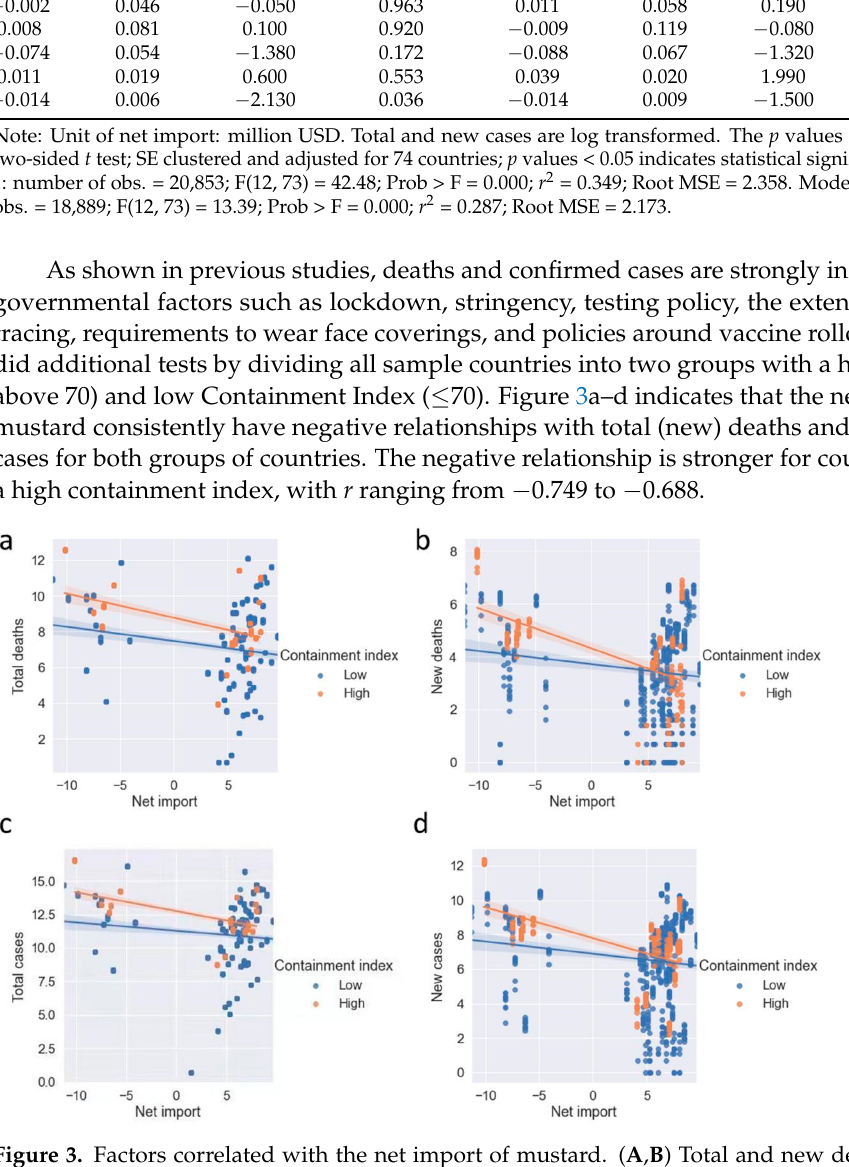
Figure 3. Factors correlated with the net import of mustard. ( A , B ) Total and new deaths caused by COVID-19 are negatively related to net import (log transformed). Brown lines represent a high containment index (>70), while blue lines represent a low containment index ( ≤ 70). ( C , D ) Total and new COVID-19 confirmed cases are negatively related to net import. The correlations are compared with different levels of the containment index.